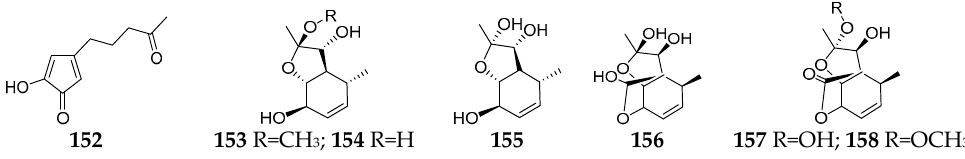
Figure 9. New SMs ( 152 – 158 ) isolated from fungal–host co-culture.